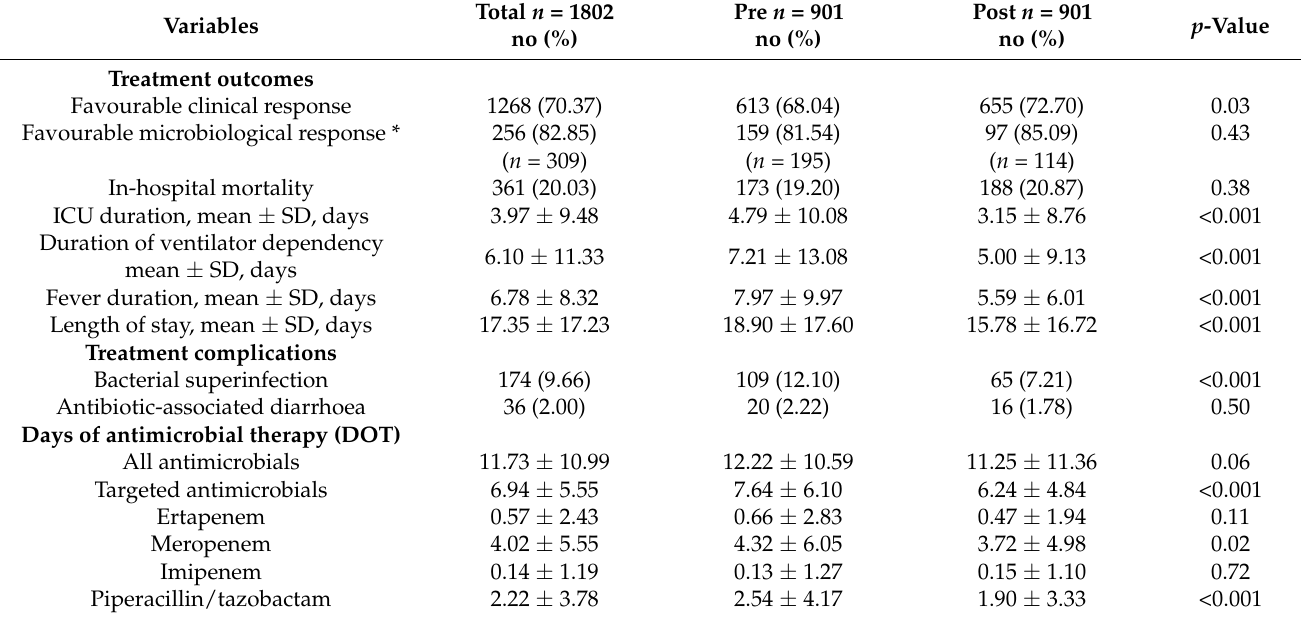
Table 3. Comparison of clinical outcomes of patients in the pre- and post-implementation